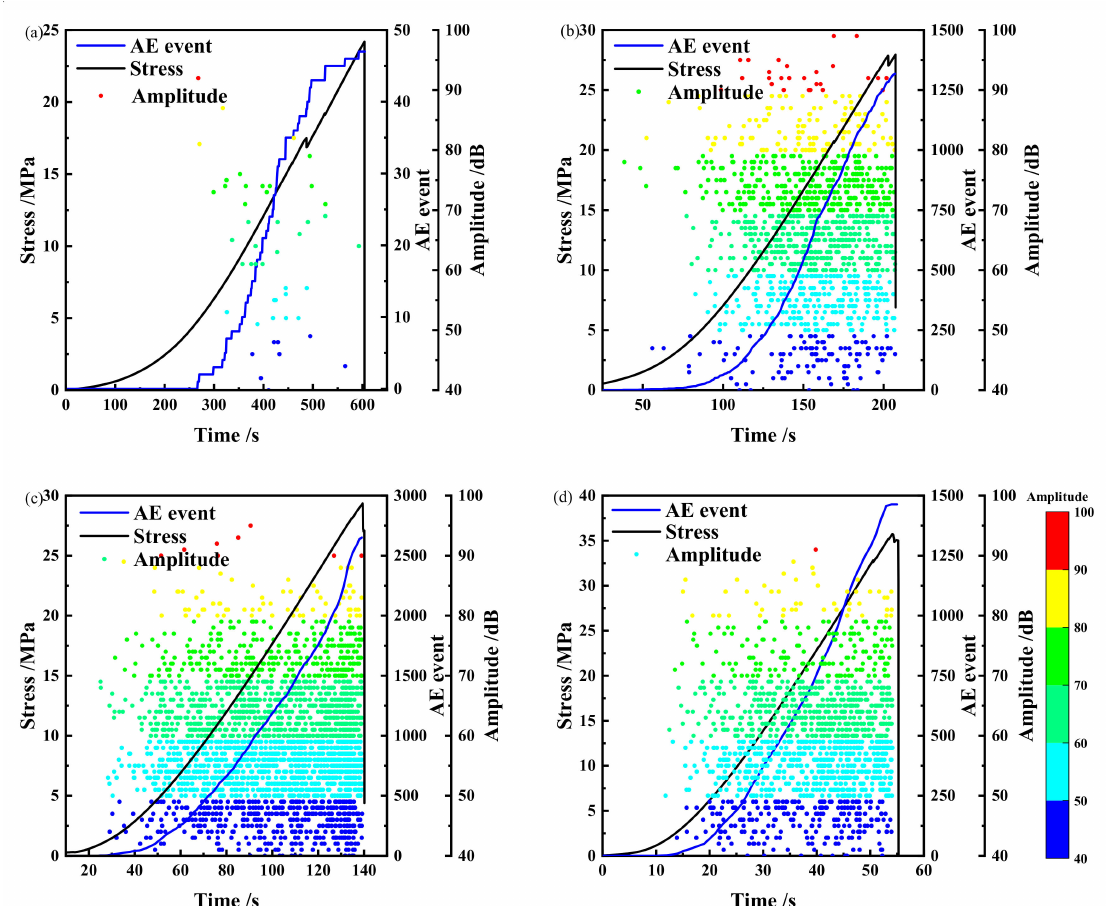
Figure 7. Evolution of stress, AE events, and amplitudes with time under different loading rates: ( a ) 0.2 mm/min, ( b ) 0.6 mm/min, ( c ) 1.0 mm/min, and ( d ) 3.0